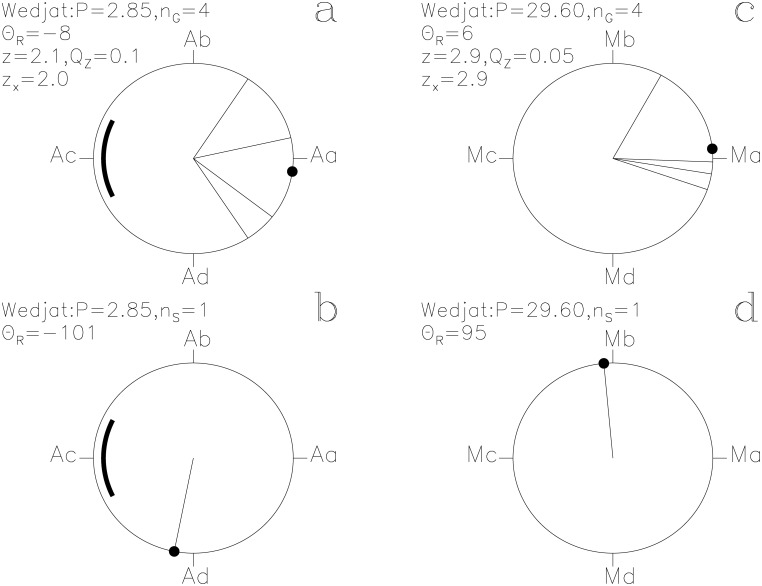
Wedjat.otherwise as in Fig 1